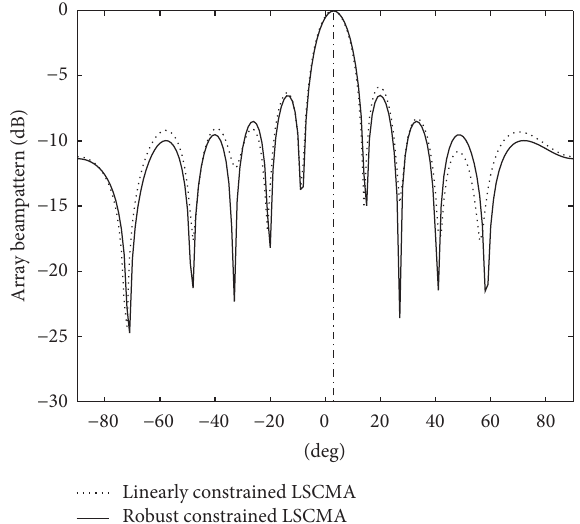
Figure 2: Array beampattern (in no mismatch case).